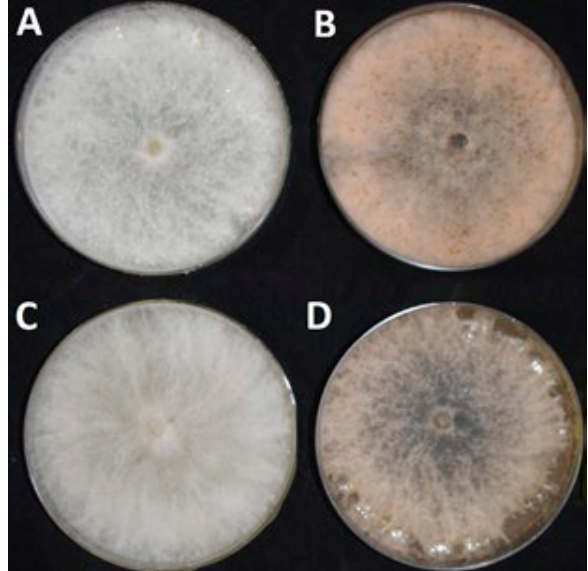
Figure 1. Isolates BCMX02 (A and B) and BCMX01 (C and D) of Eutypella microtheca grown on PDA at 28°C during 20 d in darkness (A and C), and with 12 h cycles of fluorescent light (B and